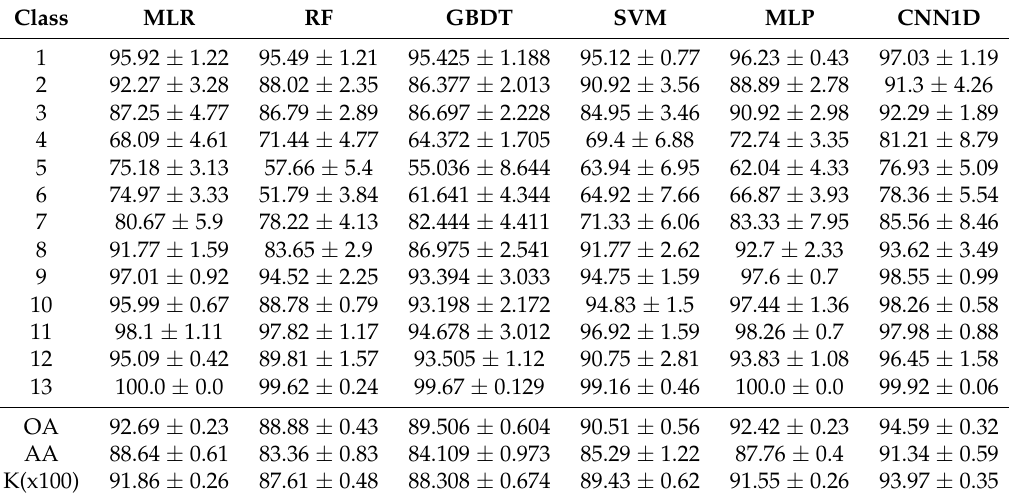
Table 7. KSC data set results.